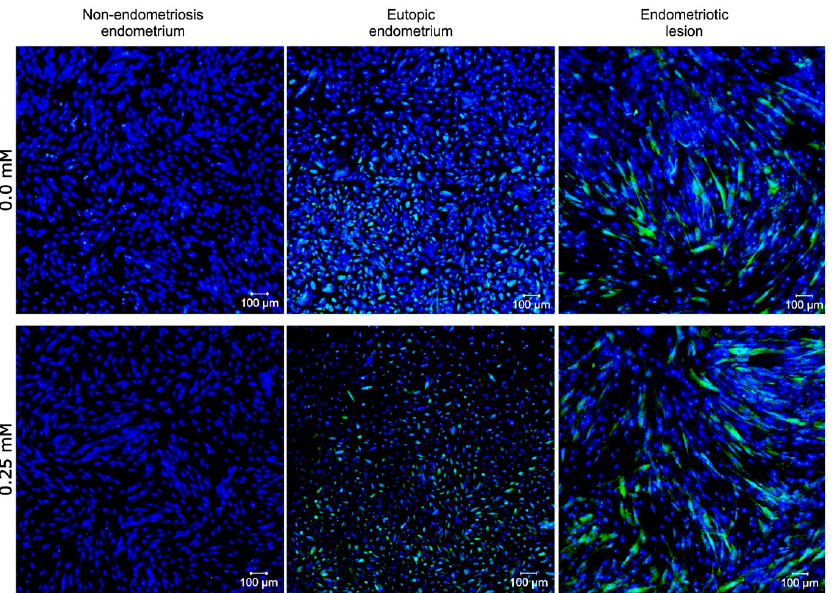
Figure 4. p16 ink4 expression in stromal cells from endometriosis and non-endometriosis endometrium. Fluorescence intensity of p16 ink4 (in green) in the stromal cells from non-endometriosis and endometriosis endometrium and endometriotic lesions at passage 6 stimulated with 0.0 mM and 0.25 mM H 2 O 2 , analyzed using indirect immunofluorescence. Nuclei were stained with DAPI (in blue).